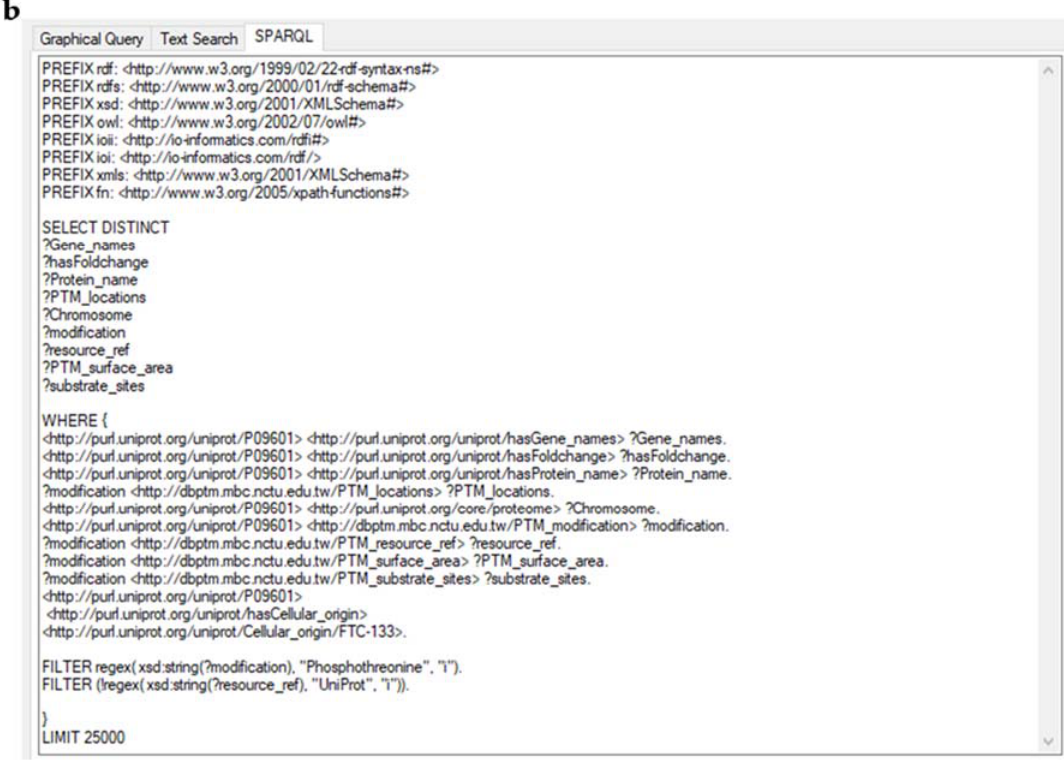
Figure 5. A typical graphical SPARQL query for searching for information about all proteins imported in the KE via a spreadsheet in databases of interest for the topic of a study (see also ref. [35]). The query shown directs KE to the dbPTM to search for substrate sites and location of modifications, as well as for the surface area covered by the modification ( a ). The graphical query is auto-translated into a SPARQL text query by KE and used for searches ( b ).